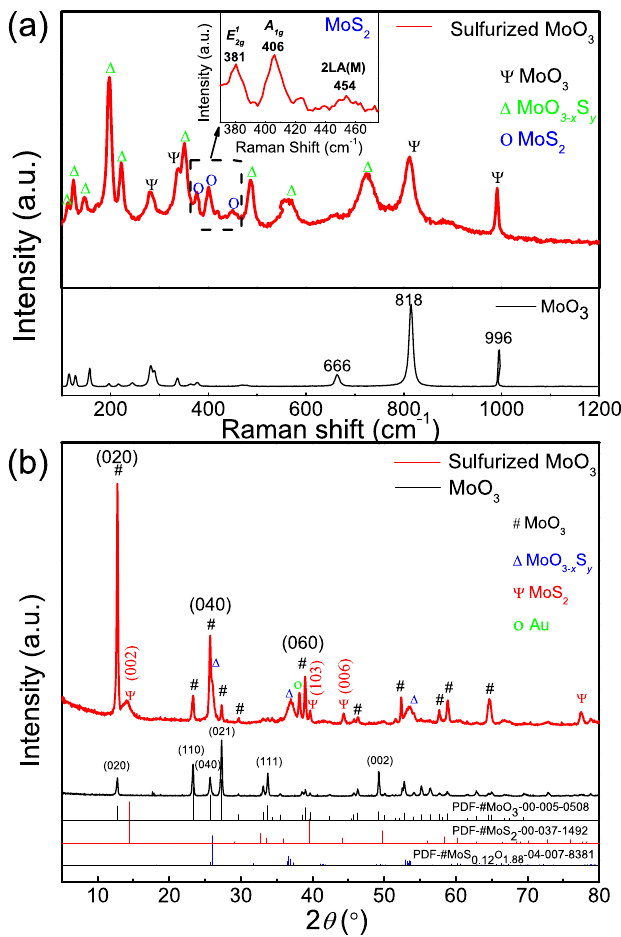
Figure 4. ( a ) Raman spectra and ( b ) XRD patterns of MoO 3 on SiO 2 /Si substrate before and after sulfurization.